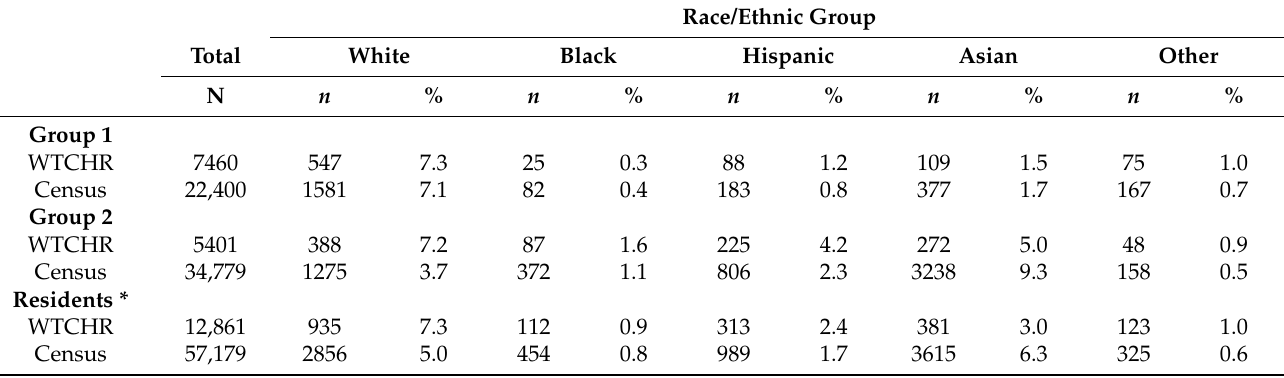
Table 3. Comparison of proportions for race/ethnic groups of WTCHR resident children < 18 years on 11 September 2001 with 2000 Census for south of Canal Street in Lower Manhattan. Denominator of proportions is Total for all residents.